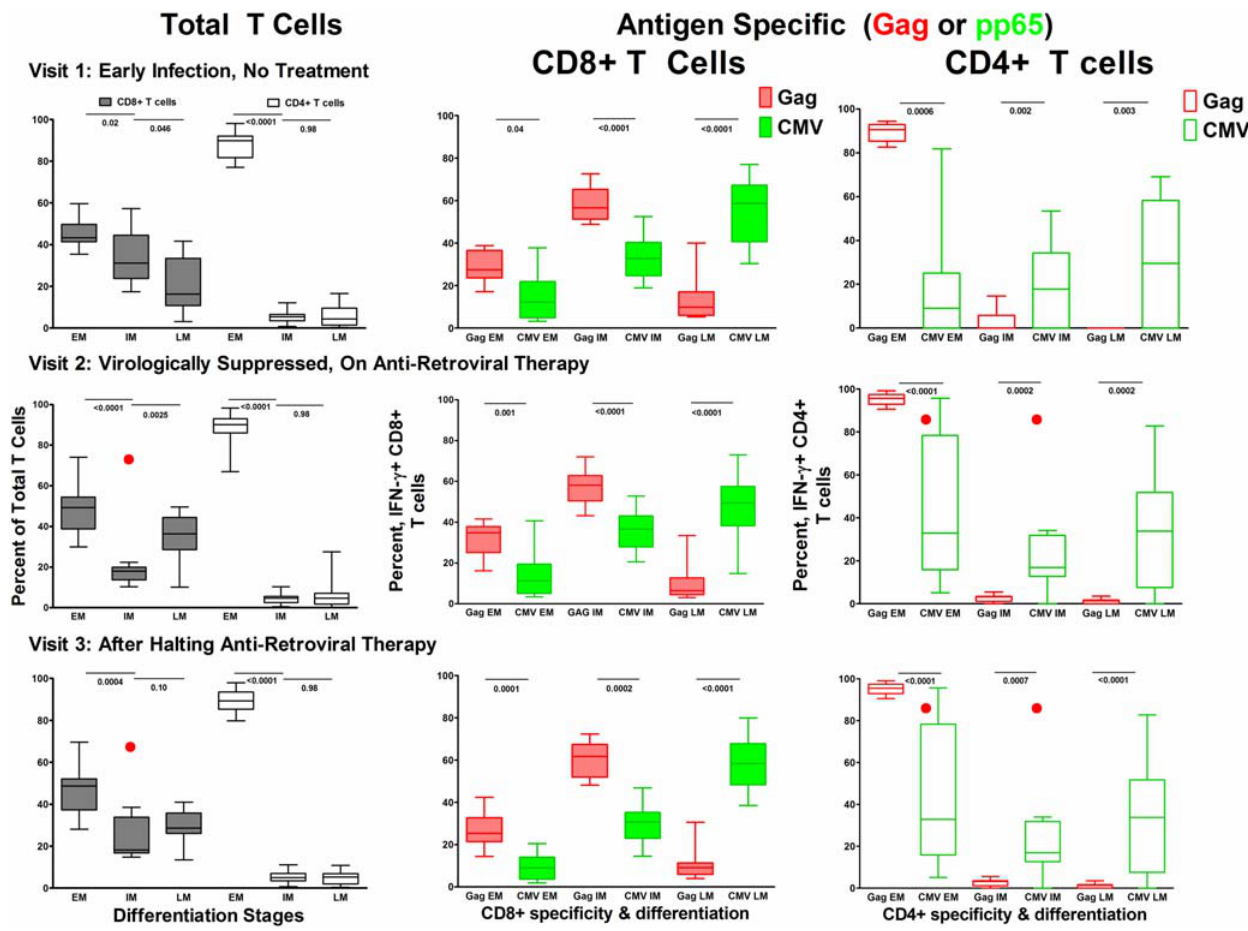
Figure 3. Differentiation profile of total and antigen specific T cells over time. In the first column the proportion of total T cells (CD8 + and CD4 + ) falling into each T cell maturation category are displayed and defined as early memory (CD27 + CD28 + ) EM, intermediate memory (CD27 + CD28 2 ) IM, and late memory (CD27 2 CD28 2 ) LM. In columns 2 the maturation profiles for CD8 + T cell IFN- c responses to both HIV-1 Gag (red) and CMV pp65 (green) are shown. And in column 3 the maturation profiles for CD4 + T cell IFN- c responses to HIV-1 Gag (red) and CMV pp65 (green) are shown. Row 1 displays measurements for visit 1, prior to antiretroviral therapy. Row 2 displays measurements for visit 2, during a virologically suppressive anti-retroviral regimen, and row 3 displays measurements for visit 3, after patients had halted an anti-retroviral regimen and viremia had rebounded. Black bars indicate differences between HIV-1 Gag and CMV pp65 responses by response category (Wilcoxon 2 Sample Test). Red dots note a significant change from baseline (visit 1) values (Sign Rank